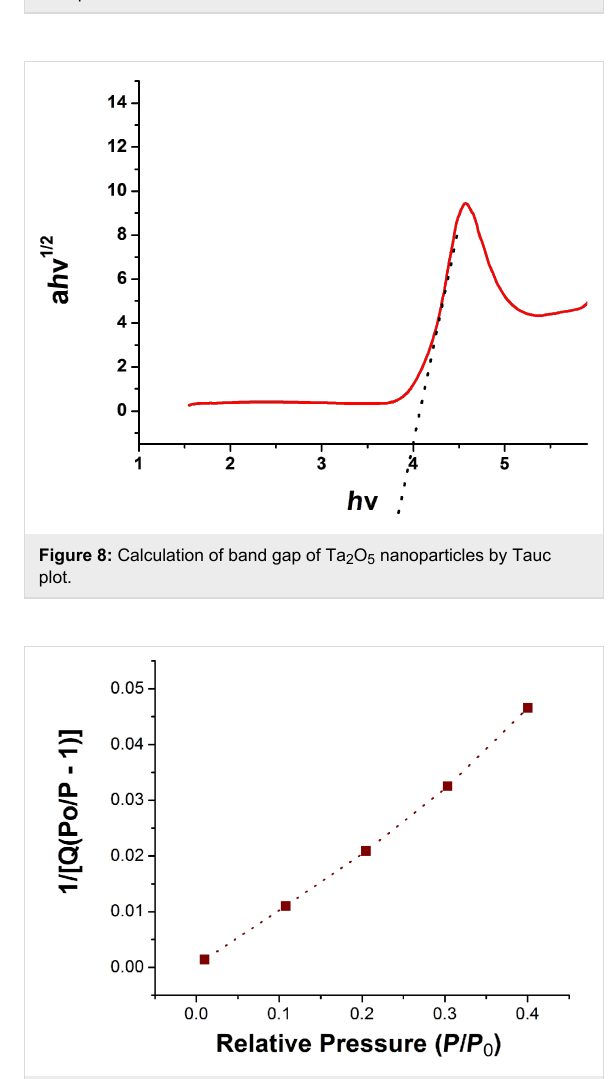
Figure 9: BET surface area plot of the calcined Ta 2 O 5